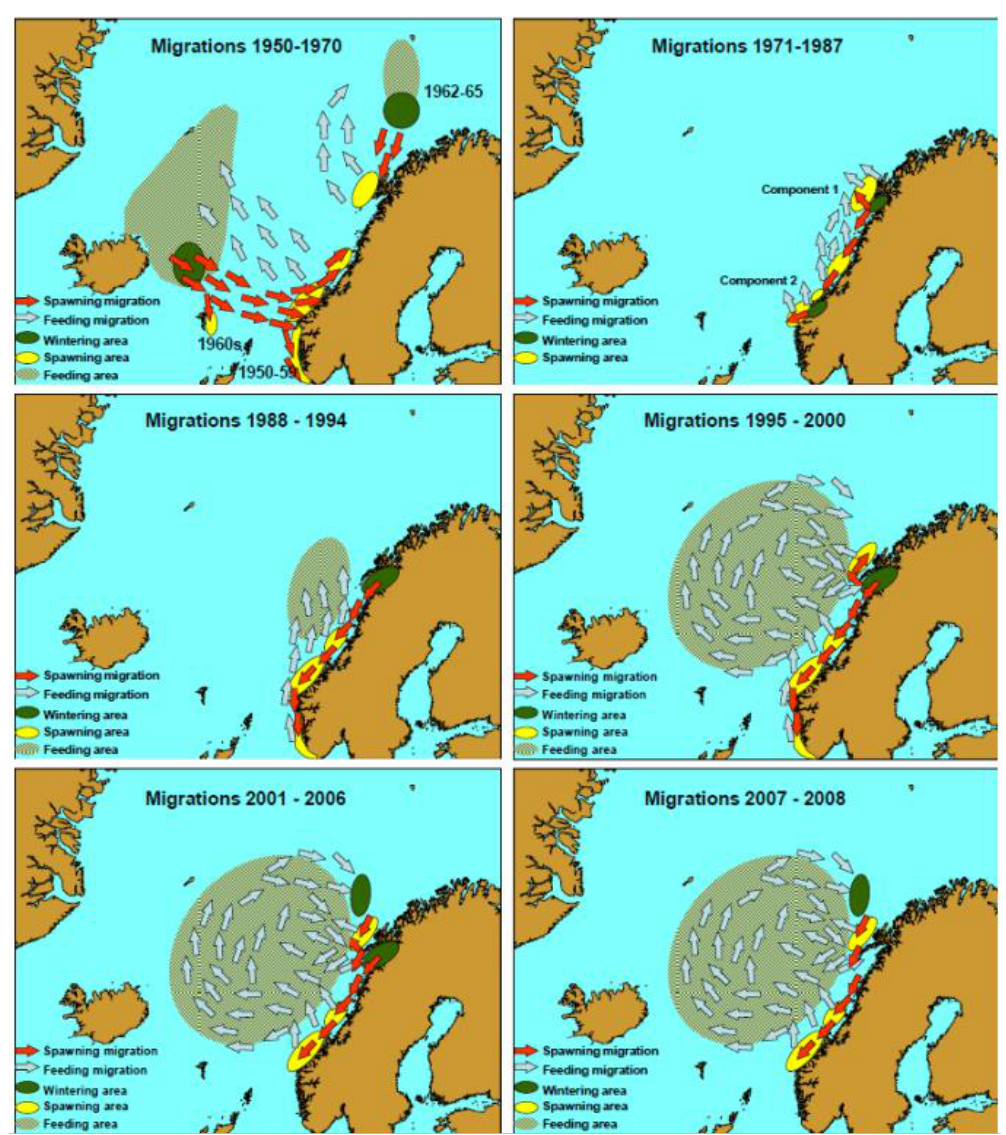
Figure 1. Schematic overview of historical changes in the adult NSS herring seasonal migration pattern. Reproduced with permission from Slotte and Skaret